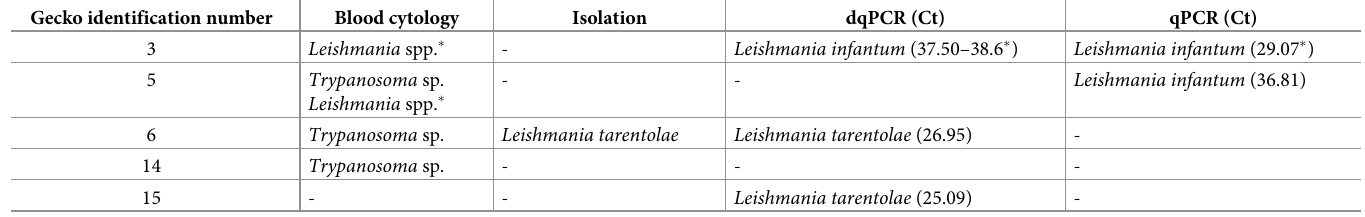
Table 1. Trypanosomatid detection in Tarentola mauritanica geckoes using blood cytology, isolation (in TE medium), dqPCR and qPCR; values of the threshold cycle (Ct) are reported. Gecko identification number